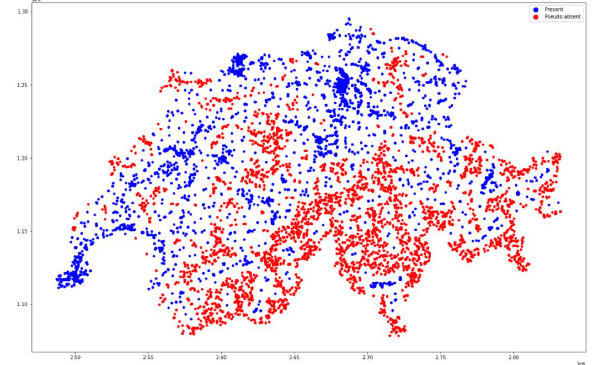
Figure 3. Presences (blue points) and Pseudo-absences (red points) for Carrion Crow in Switzerland